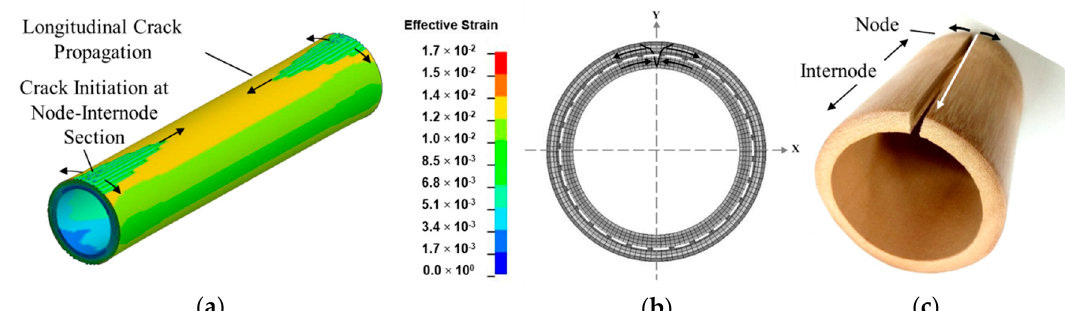
Figure 14. Failure mechanisms of bamboo due to shrinkage: ( a ) fringe plot of effective strain of internode section in exponential shrinkage model depicting crack initiation and propagation by implementing an element erosion technique; ( b ) node-internode transverse section showing layered innermost and outermost regions induced with compressive and tensile forces, respectively and ( c ) longitudinal split in natural bamboo.